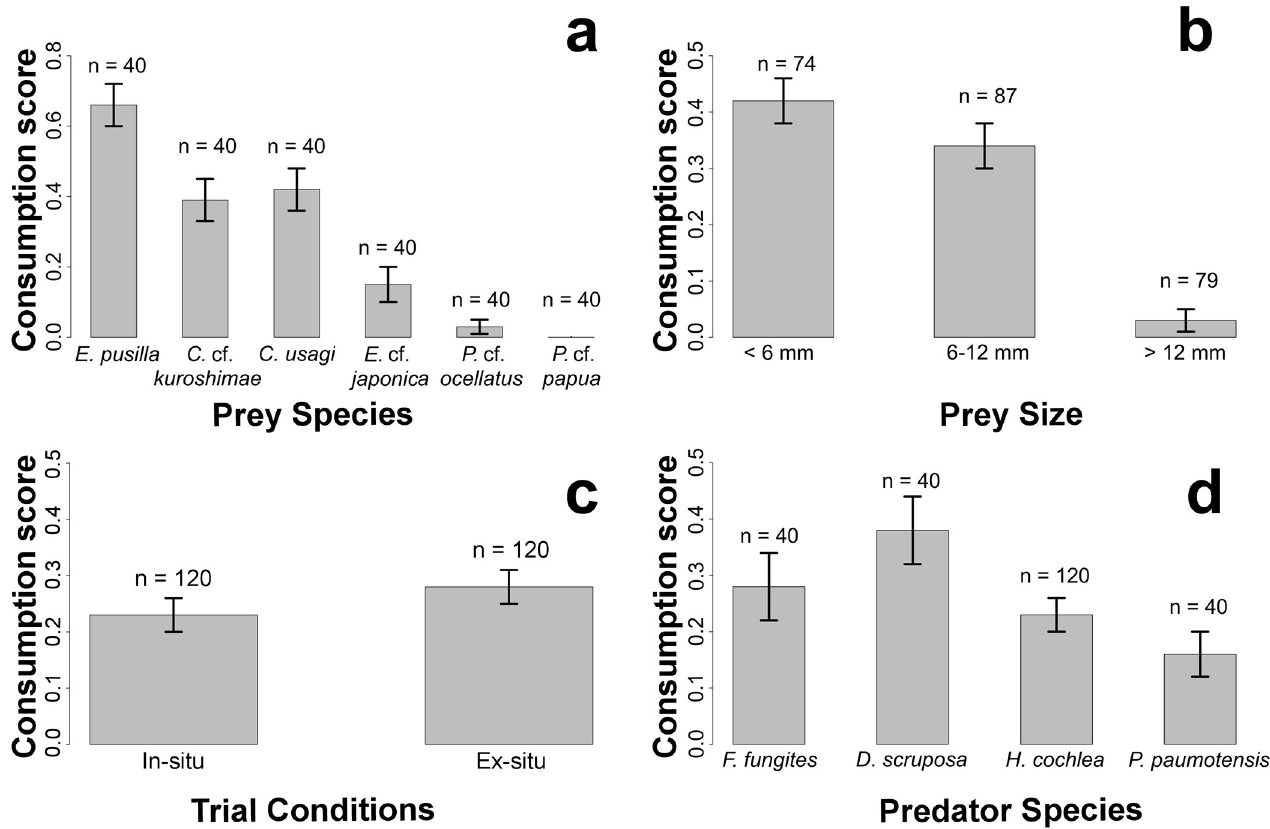
Fig 6. Comparison of mean consumption scores between a) prey sacoglossan species b) prey size classes c) in-situ and ex-situ feeding trials and d) predator corals. Error bars represent standard error and y-axis indicates consumption score from 0 (no visible tissue loss) to 1 (heavy tissue degradation).